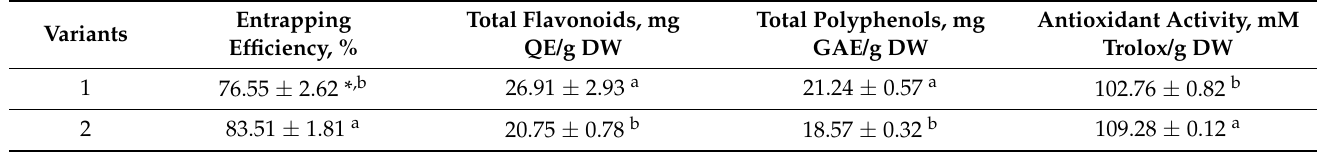
Table 1. Global phytochemical profile of the